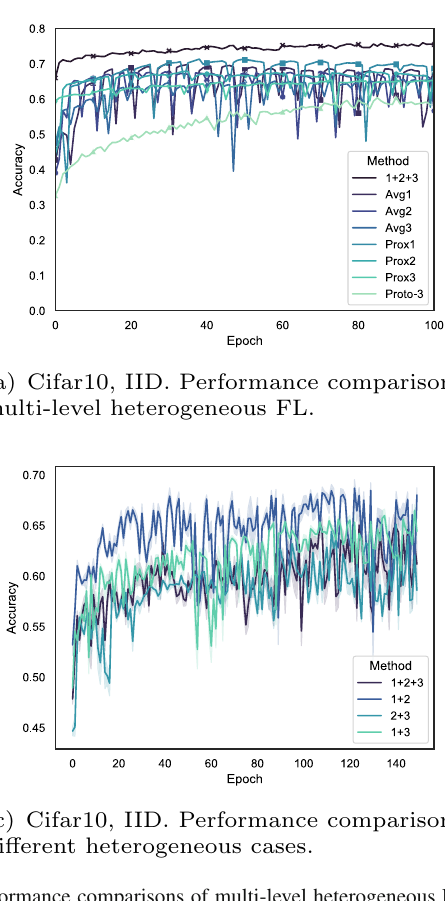
Fig. 7 Performance comparisons of multi-level heterogeneous FL (shown in a and b ) and performance comparisons of different heterogeneous cases (shown in c and d ) when the dataset is Cifar10